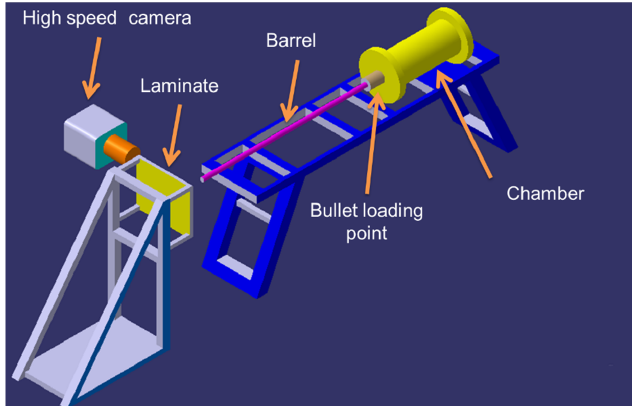
Polymers 2021 , 13 , x FOR PEER REVIEW Figure 2. Schematic of experimental high velocity impact test setup. Figure 2. Schematic of experimental high velocity impact test setup.